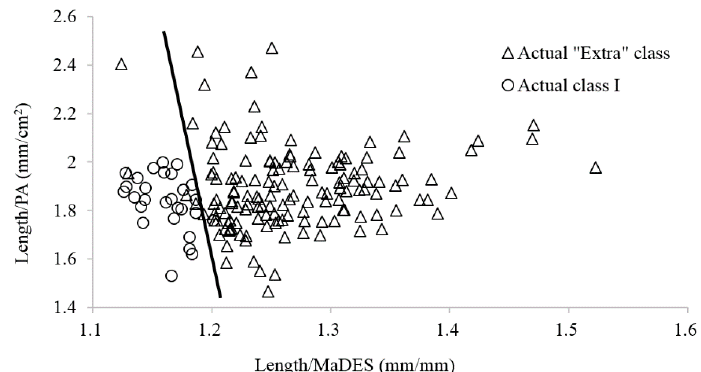
Figure 5. Improved classifications of samples in the estimated “Extra” class based on a linear correlation between the length/MaDES and length/PA values.